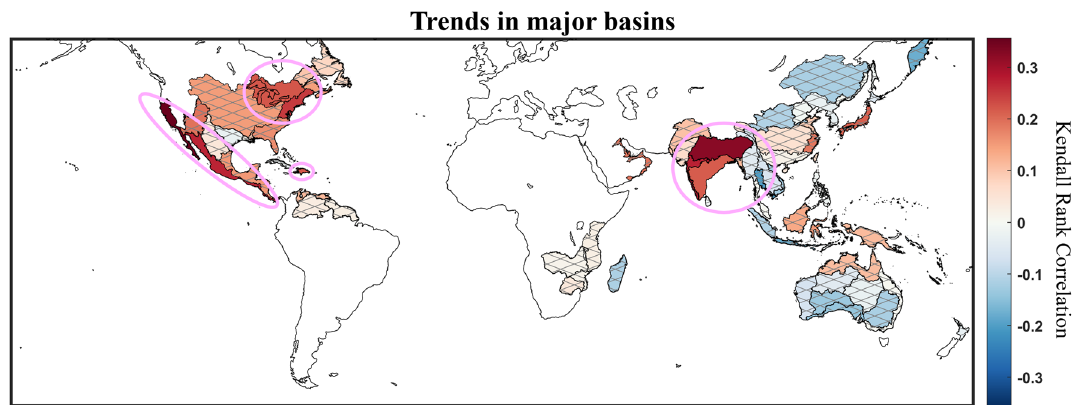
Figure 5. Inland precipitation accumulation trends from 1980–2019 calculated at the major river basin scale. Regions of non-significant trends are indicated by gray hatching. Pink circles denote regions where inland penetration from TCs have been heightened